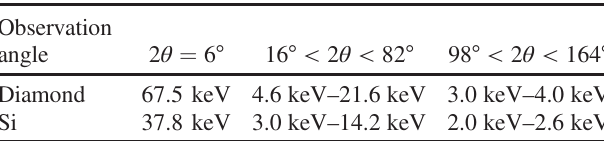
TABLE III. Basic parameters of diamond and Si crystals. Crystal